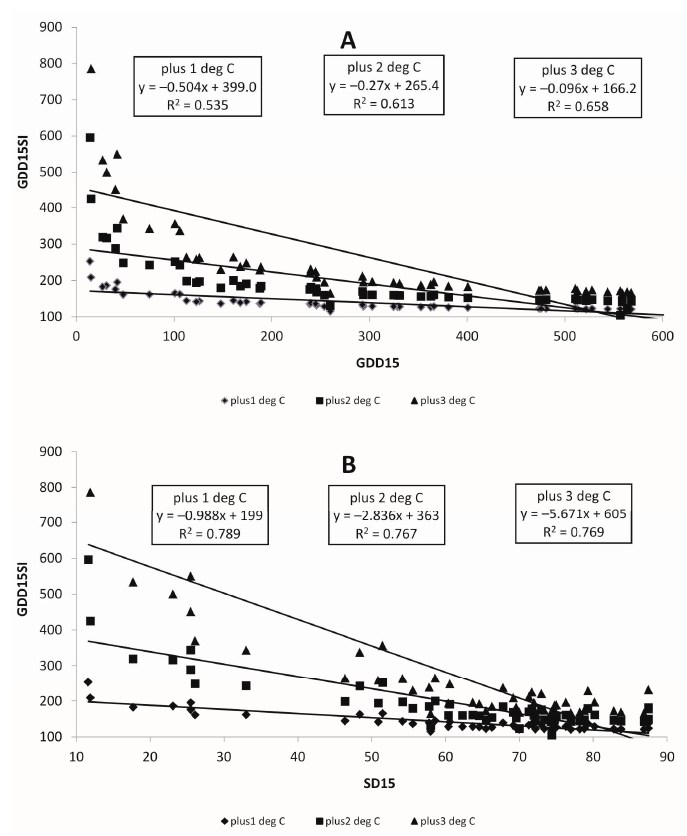
Figure 11. Relationship between growing degree days with 15 °C threshold (GDD15), its standard deviation (SD15) and Sensitivity Index (GDD15SI) for locations in the Russian Far East for the period 1966 – 2017 for +1, +2 and +3 °C warming scenarios: ( A ) for GDD15, ( B ) for SD15.